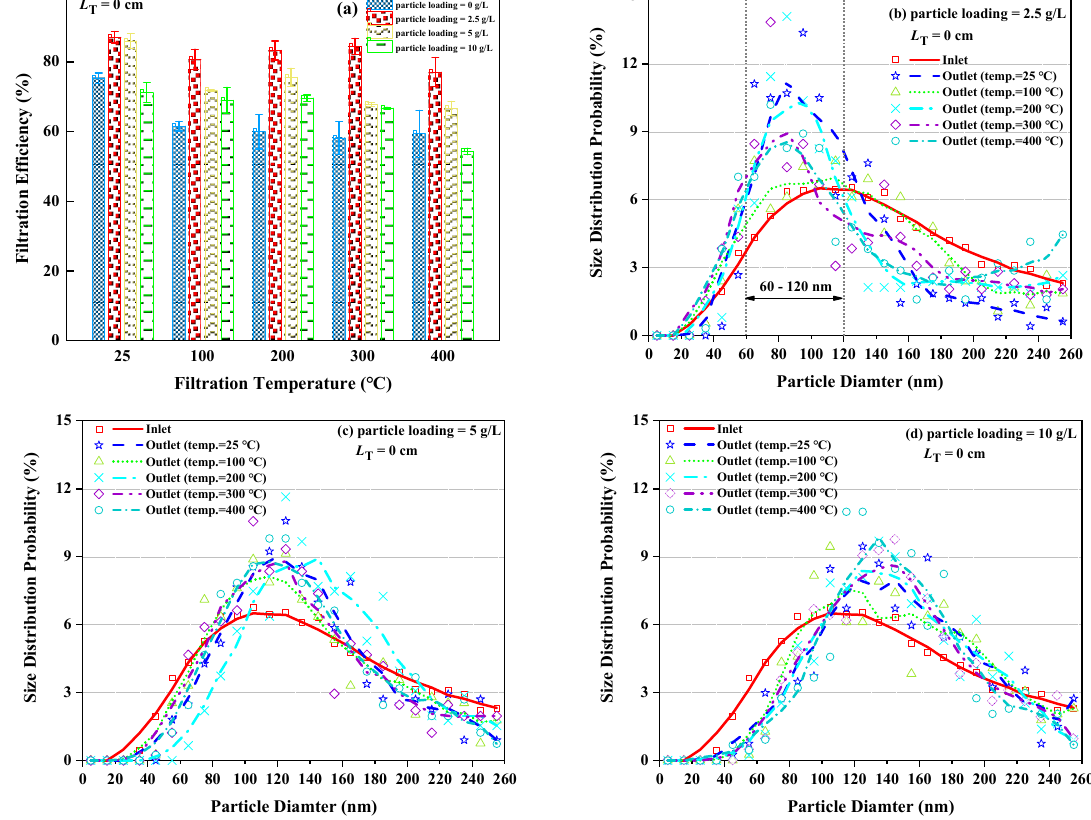
Figure 6. ( a ) The filtration efficiency of particle loading from 0 g/L to 10 g/L; particle size distribution probability of different temperatures in DPF inlet and outlet with transition section length L T of 0 cm under different particle loadings: ( b ) 2.5 g/L; ( c ) 5 g/L; ( d ) 10